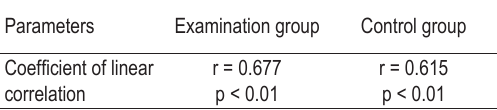
TABLE 1. The coef fi cient of linear correlation between T score and daily intake of dietary calcium among women with- out estrogen de fi ciency in menstrual